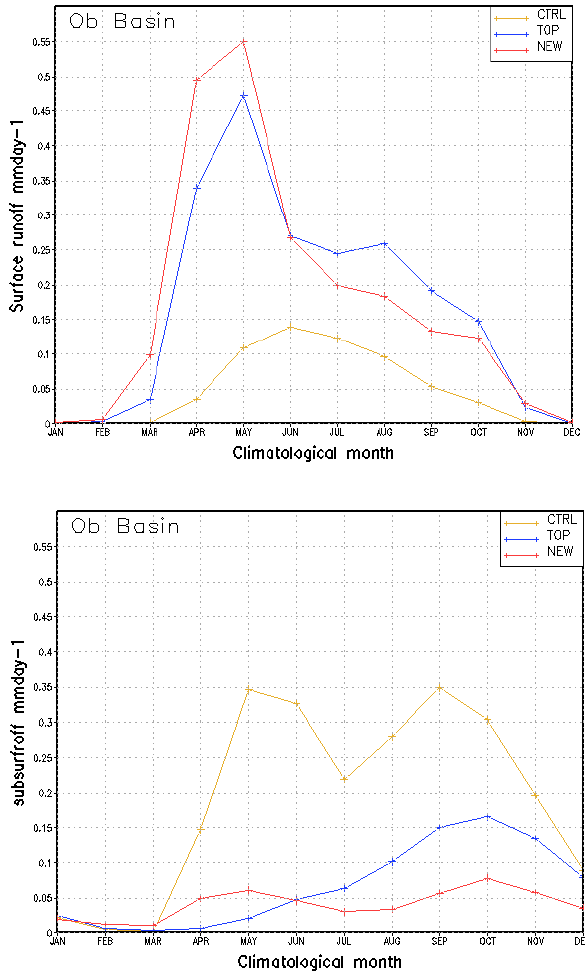
Fig. 7. Average monthly surface and subsurface runoff over the Ob. This is a plot of climatological area-average values over model runs for 1989-99. 5